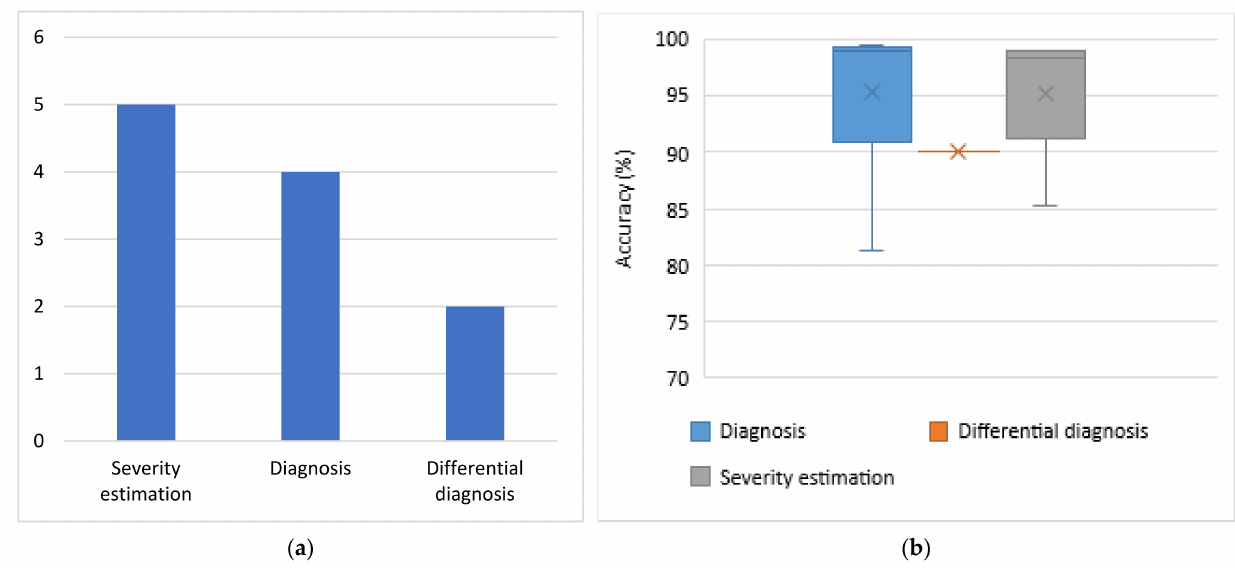
Figure 6. PD problems addressed based on pressure sensors and the respective obtained accuracies. ( a ) Number of studies per task; ( b ) accuracies obtained from the proposed models for each category of addressed tasks. Number of studies considered in this boxplot per task: n = 4 for diagnosis, n = 1 for differential diagnosis and n = 5 for severity